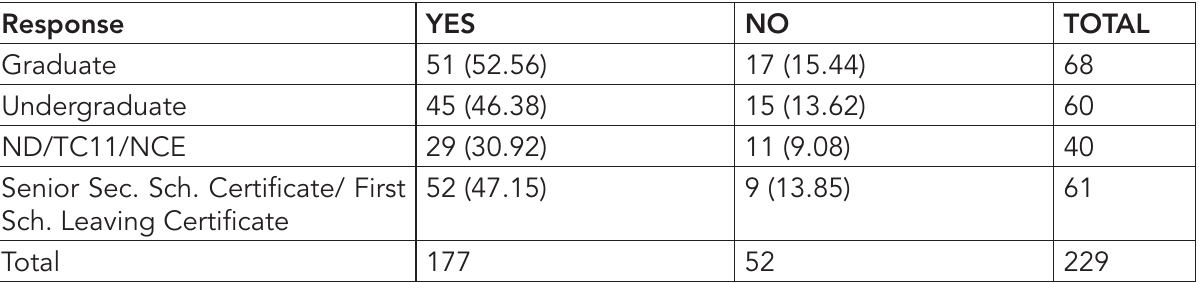
Table 3: Regularity of